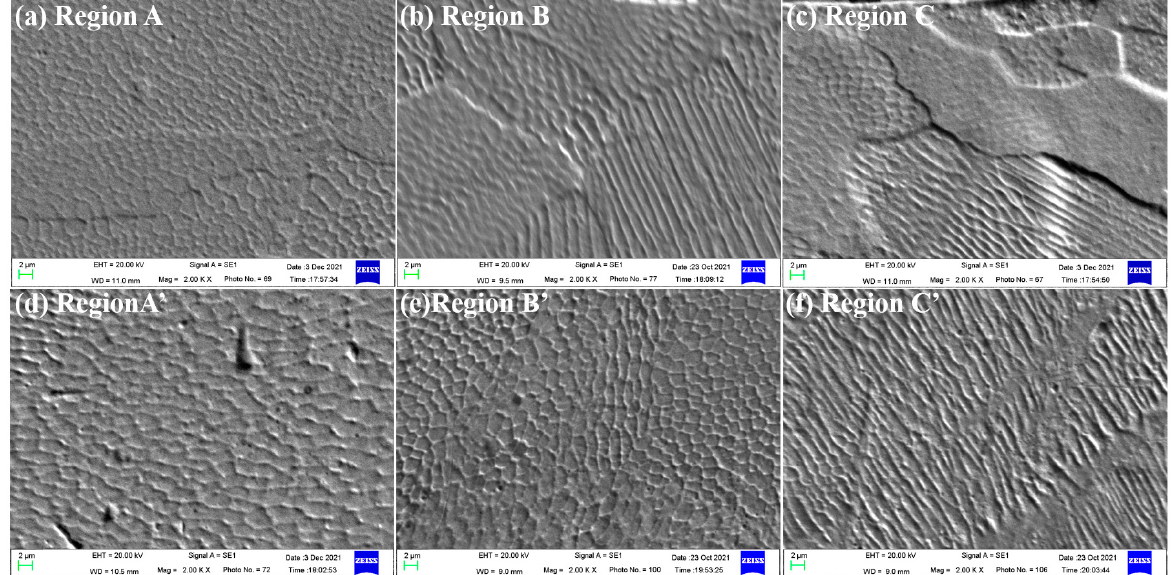
Figure 6. Solidification microstructure at different regions of the molten pool. In pure argon: ( a ) 304SS side, A region; ( b ) substrate interface, B region; ( c ) nickel side, C region. In the AMO: ( d ) 304SS side, A’ region; ( e ) substrate interface, B’ region; ( f ) nickel side, C’ region. The solidification microstructure was determined by the temperature gradient